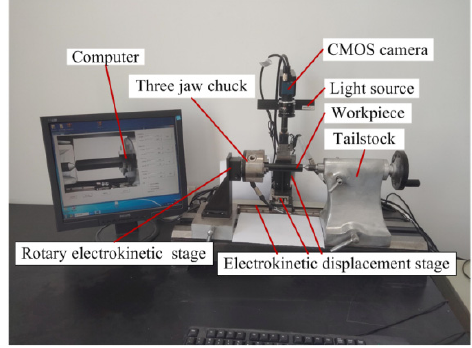
Figure 2. Form deviation detection system by machine vision. Table 1. Main hardware of the system. Table 2. Specification of motion